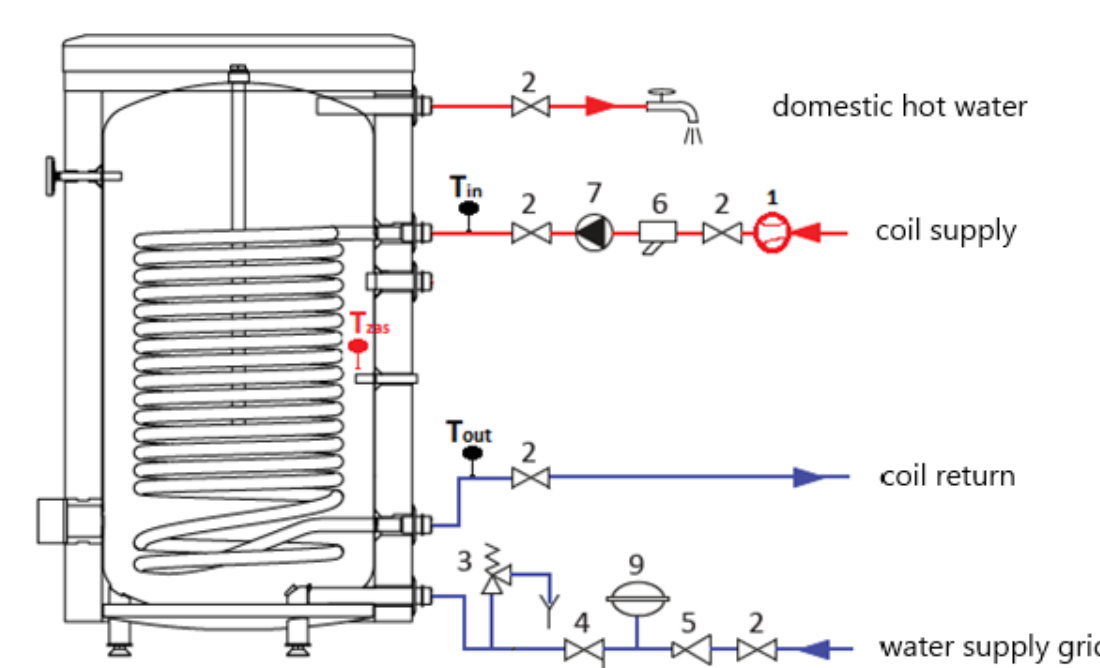
Figure 6. Schematic diagram of the storage tank with temperature and flow rate measurement points.